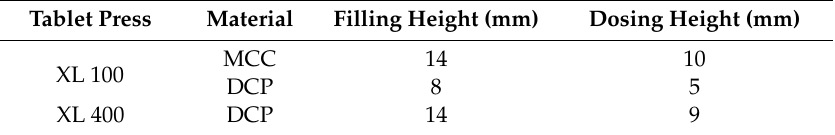
Table 2. Applied machine settings for RTD experiments on XL 100 and XL 400.